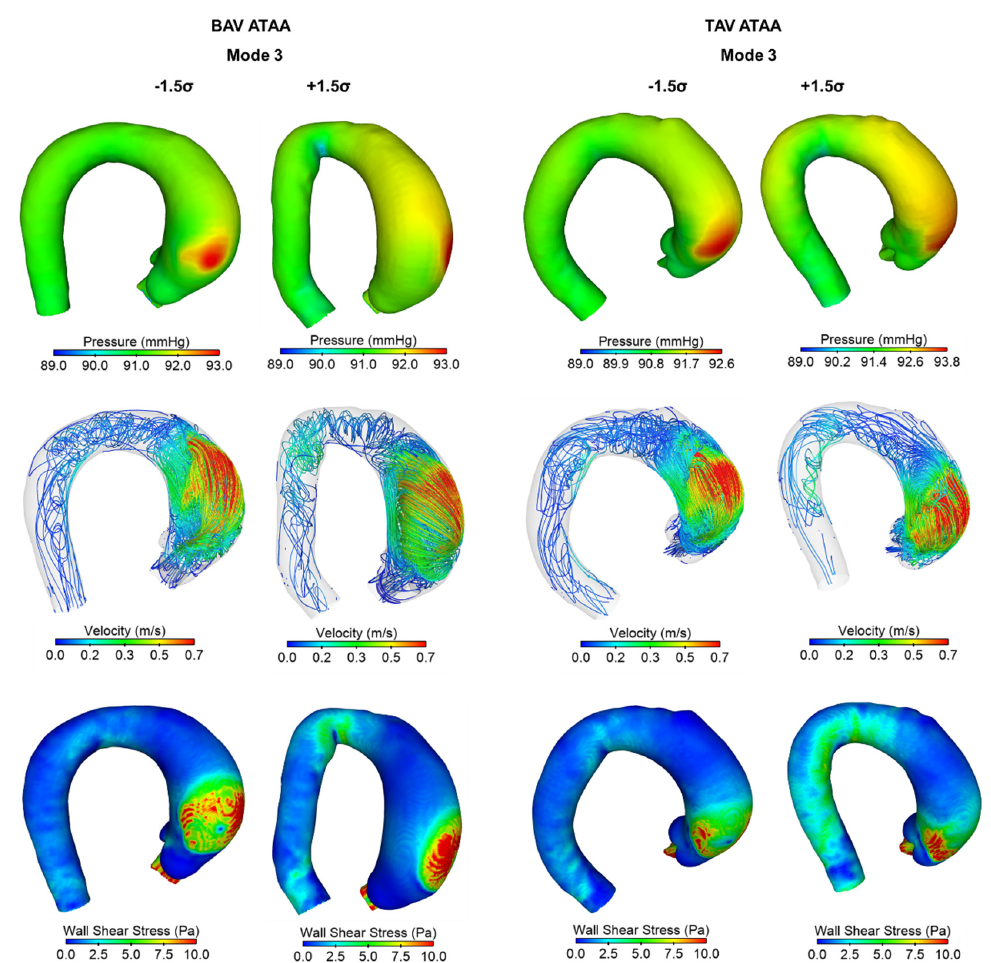
Figure 8. Pressure ( top ), flow velocity ( center ), and WSS ( bottom ) for BAV and TAV ATAA models for Mode 3 at ±1.5 σ .